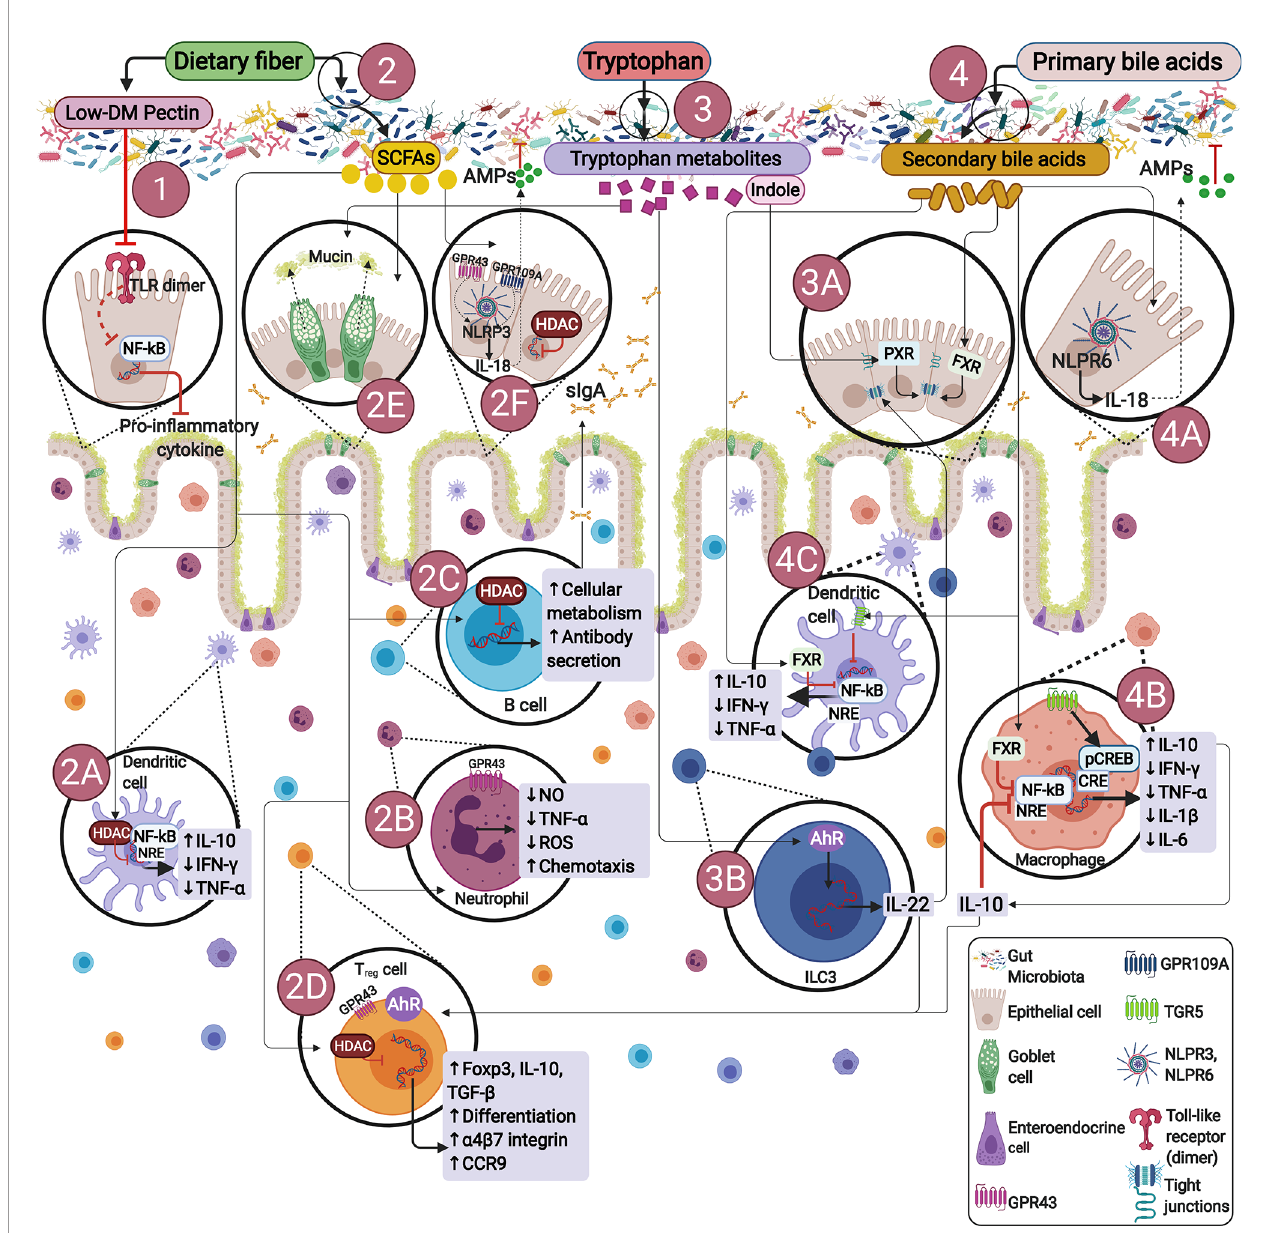
FIGURE 1 | Endogenous or dietary compounds and dietary-derived bacterial metabolites effects on the gut immune barrier. (1) Direct effect of dietary fi ber. Some dietary fi bers have been shown to have direct effects on immune cells. E.g., low degree of methyl esteri fi cation (Low-DM) pectin binds to TLR2, inhibiting TLR2-1 heterodimer activation, thus reducing NF- k B activation. (2) Bacterial fermentation of dietary fi ber by SCFAs-producing bacteria. SCFAs inhibit histone deacetylases (HDACs) and thus NF-kB-induced pro-in fl ammatory mediators: (2A) induce neutrophil chemotaxis by binding to GPR43, (2B) promote IgA secretion (2C), stimulate Tregs proliferation and differentiation by activating GPR43 and inhibiting HDACs (2D), in fl uence NLRP3 by activating GPR43 or GPR109A facilitating IL-18 expression, thus promoting repair and maintaining barrier function (2E, 2F). (3) Bacterial tryptophan metabolism: Indole promotes epithelial barrier function through the pregnane X receptor (PXR). Bacterial tryptophan metabolites are AhR ligands in ILCs, ROR g t interacts with AhR stimulating IL-22 expression (3A, 3B), IL-22 promotes antimicrobial peptide expression and enhances goblet cell proliferation for mucin secretion (2E). (4) Bacterial bile acid metabolites: Gut metabolites-derived from microbiota, endogenous or dietary compounds participate in microbiota-host interactions, exerting diverse effects on epithelial or immune cells through different signaling pathways. Secondary bile acids regulate epithelial integrity by binding to the farnesoid X receptor (FXR) in epithelial cells (4A), regulate macrophages differentiation into M2 pro fi le via TGR5 and FXR activation, reversing in fl ammatory pathways producing IL-10 (4B), with further IL-10 production by Treg (2D). Additionally, TGR5 signaling involves NF- k B inhibition, and FXR signaling repressing NF- k B-responsive elements (NRE) in macrophages and dendritic cells (4B,